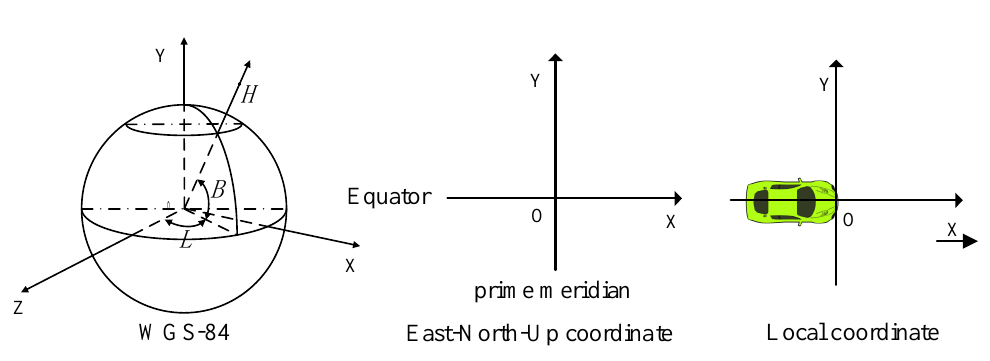
Figure 4. Transformation of coordinate systems.